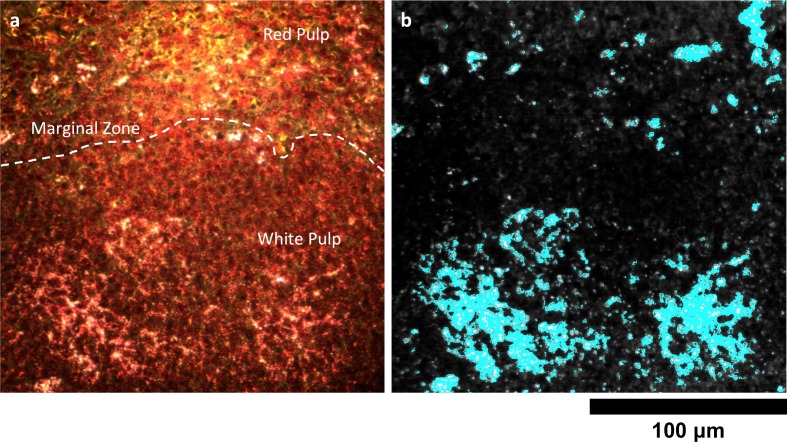
Detail of Nanoshell uptake in spleen tissue.(a) Conventional dark-field image of H&E-stained spleen tissue. The dashed white line approximately demarcates the marginal zone separating the red and white pulp. (b) HSM-AD indicates that, unlike LGNRs, Nanoshells are localized within white pulp follicles 24 hr after intravenous injection.